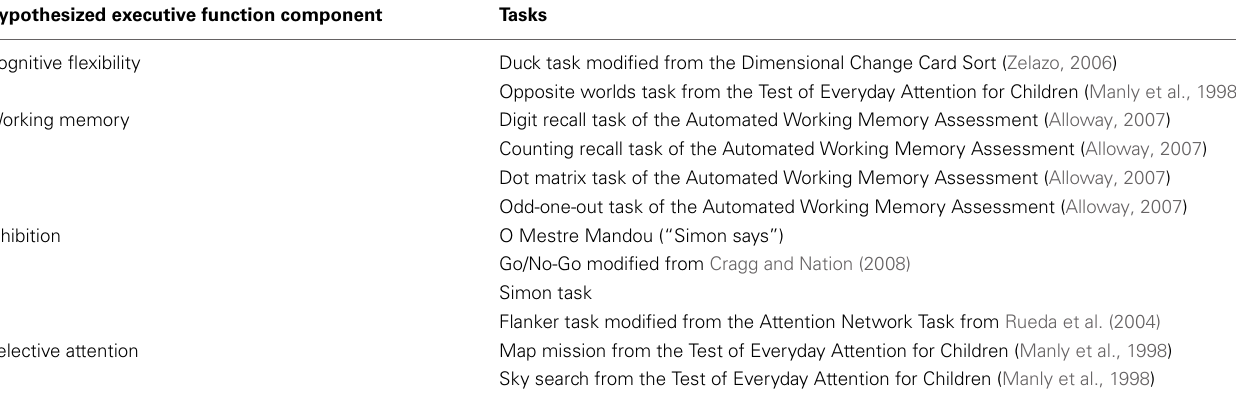
Table 2 | Executive function measures selected for this study.